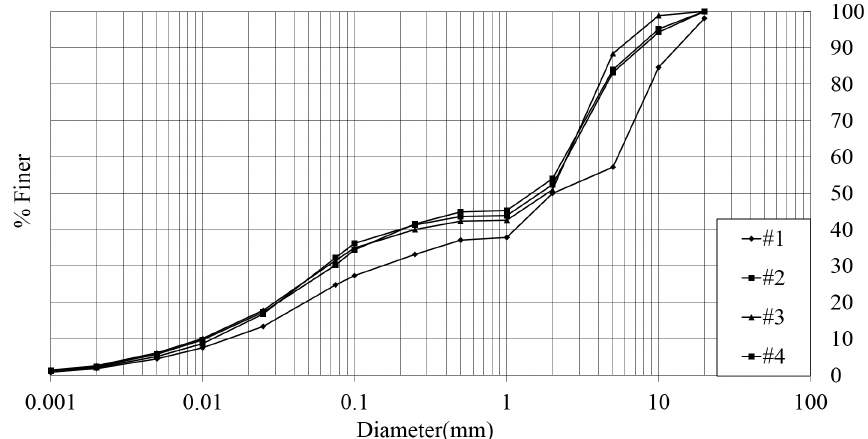
Figure 3. Particle size distribution of the waste filling (with sieve sizes of 20, 10, 5, 2.0, 1, 0.5, 0.25, 0.10, 0.075, 0.025, 0.01, 0.005, 0.002, and 0.001mm).